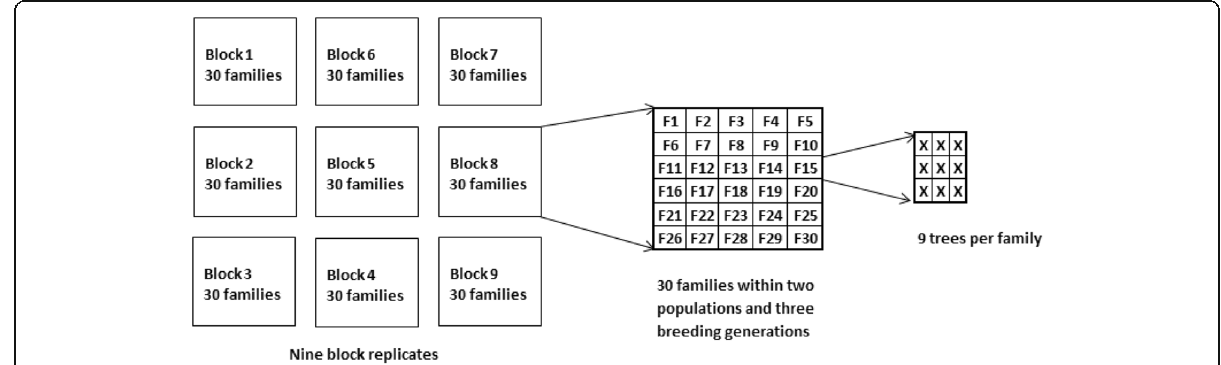
Fig. 1 Schematic diagram for field trial layout. Families were randomised within